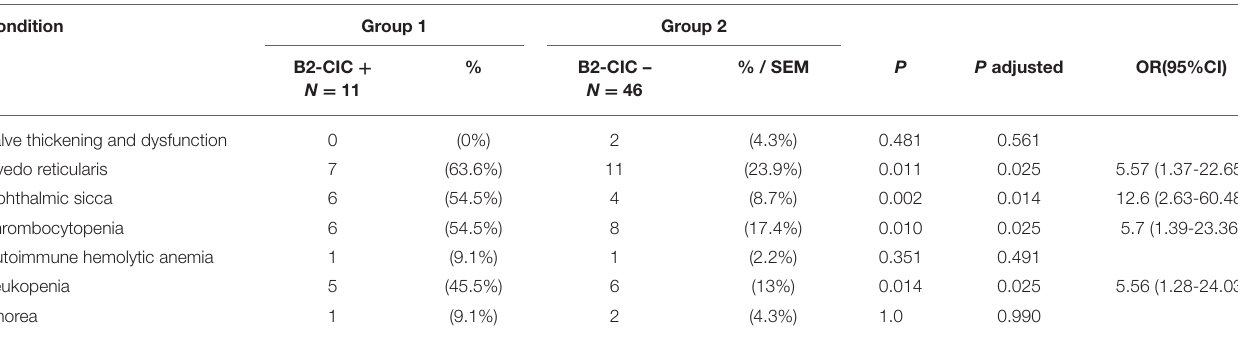
TABLE 2 | Extra-criteria clinical manifestations of antiphospholipid syndrome.